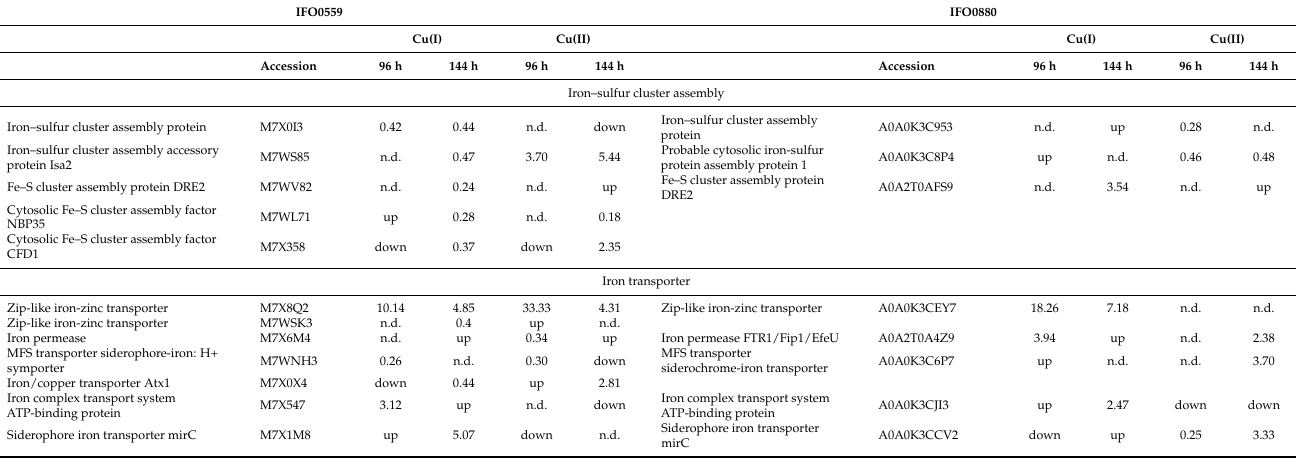
Table 2. Differentially expressed proteins involved in iron-sulfur cluster assembly and iron transport discussed here. For IFO0559 and IFO0880, fold change of samples grown under Cu(I) and Cu(II) stress was compared to respective control. Protein names and UniProt accession numbers are listed. Further fold changes at 96 h and 144 h of samples are stated. Fractions below 1 depict downregulation. n.d. = not detected; up = upregulated below cut-off score; down = downregulated below cut-off score. Cut-off score: significance ≤ 2 or fold change ≤